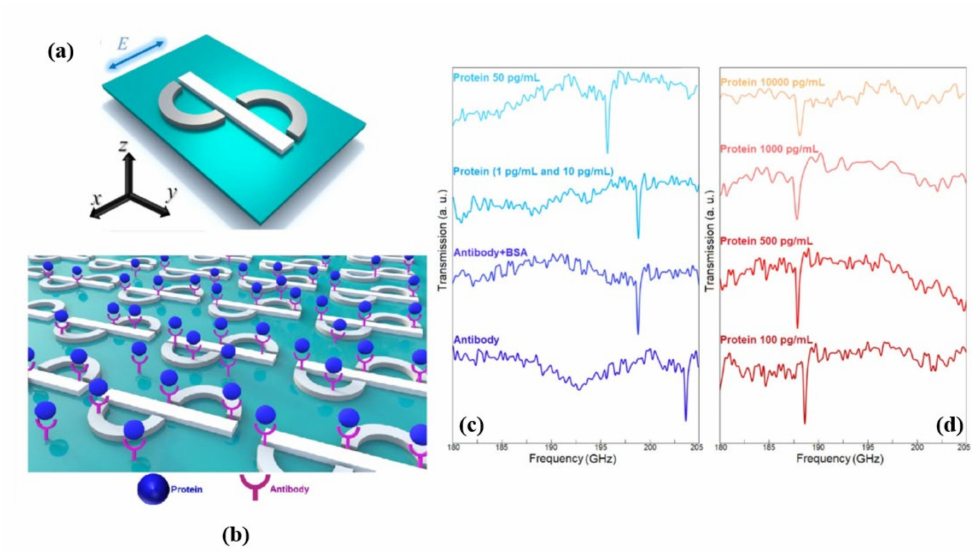
Figure 7. ( a ) Artistic perspective of compositional plasmonic resonators, ( b ) schematic demonstration of ZIKV envelope protein binding with respective antibody and transmission spectra for the toroidal resonant mode behavior for presence of different concentration of ZIKV envelope protein from ( c ) antibody to 50 pg/mL and ( d ) 100 pg/mL to 104 pg/mL. Reprinted with permission from [59]. Copyright 2017 American Chemical Society.